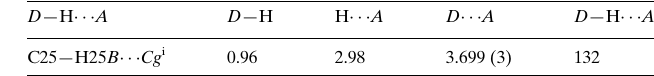
Hydrogen-bond geometry (A˚ , (cid:2)